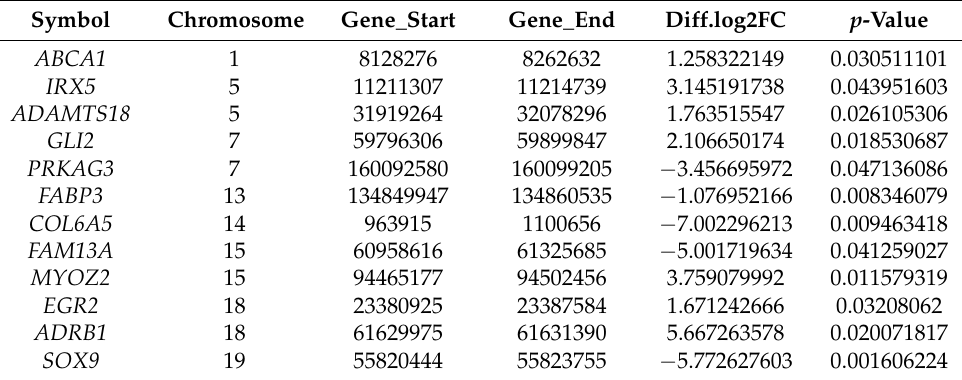
Table 4. Difference analysis of fat related genes between muscle and fat tissues.